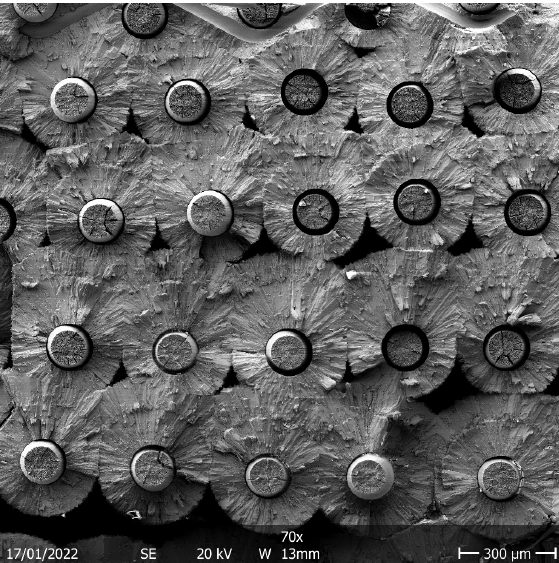
Figure 18. Fibre necking visible in the crack surface of the medium-sized sample